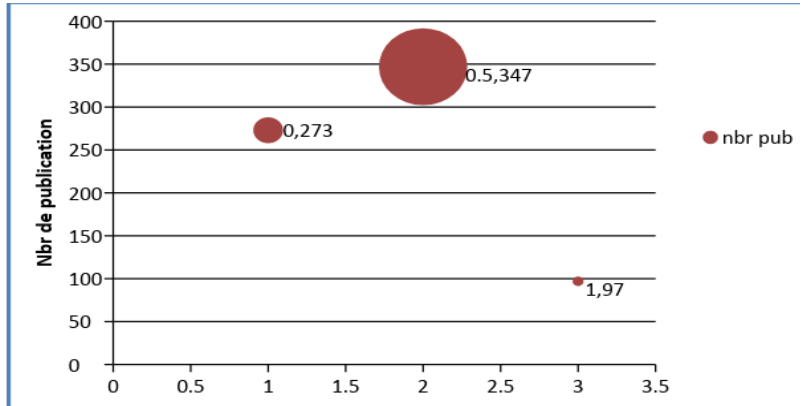
Fig. 5. The number of publications of the top-ranked affiliations by